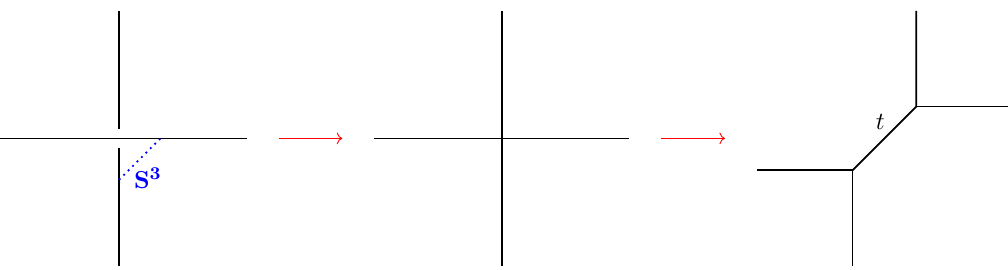
Figure 23 . The toric structure of the deformed (left), singular (middle), and resolved (right) conifold geometries, displaying the geometric transition. We display the two plane R 2 coordinatized by ( r (cid:11) ; r (cid:12) ) and draw thereupon the loci where the cycles of the T 2 degenerate. The third direction normal the plane of the paper is r (cid:13)